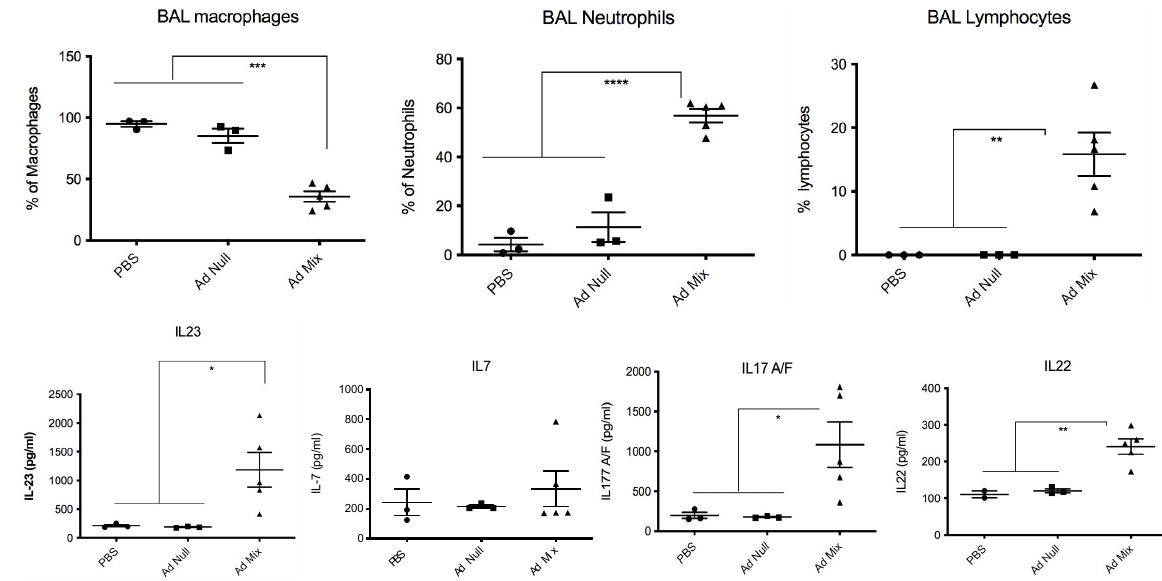
Figure 8. Intra-pulmonary instillation of Adenovirus (Ad)-IL-1β + Ad-IL-23 + Ad-IL-7 up-regulates BAL IL-17, IL-22 accumulation with concomitant BAL neutrophilic and lymphocytic influx. Male C57/Bl6 WT mice were treated intratracheally, through the oro-pharyngeal route at day 0 with either PBS ( n = 3), with Ad-null (9.10 7 pfu, n = 3) or Ad-mix (3.10 7 pfu Ad-L1β + 3.10 7 pfu Ad-IL-23 + 3.10 7 pfu Ad-IL-7, n = 5). Forty-eight hours later, mice were culled, BAL were performed for differential cell analysis (cytospins) and for cytokine measurements (ELISA). Statistical significance was assessed with the ANOVA test, followed by Tukey post hoc multivariate analysis. * p < 0.05; ** p < 0.01; *** p < 0.005; **** p < 0.001.